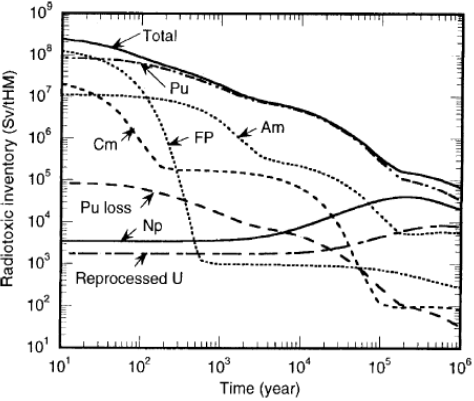
Figure 32. Radiotoxic evolution of a UOX reactor inventory over time, showing the long-term dominance of plutonium, followed by americium, curium and neptunium (Figure 1 in [154]), thus indicating the benefits of transmutation. Fission products (FP) contribute radiotoxicity only up to 500 years. © 2005 Elsevier, reproduced with permission.